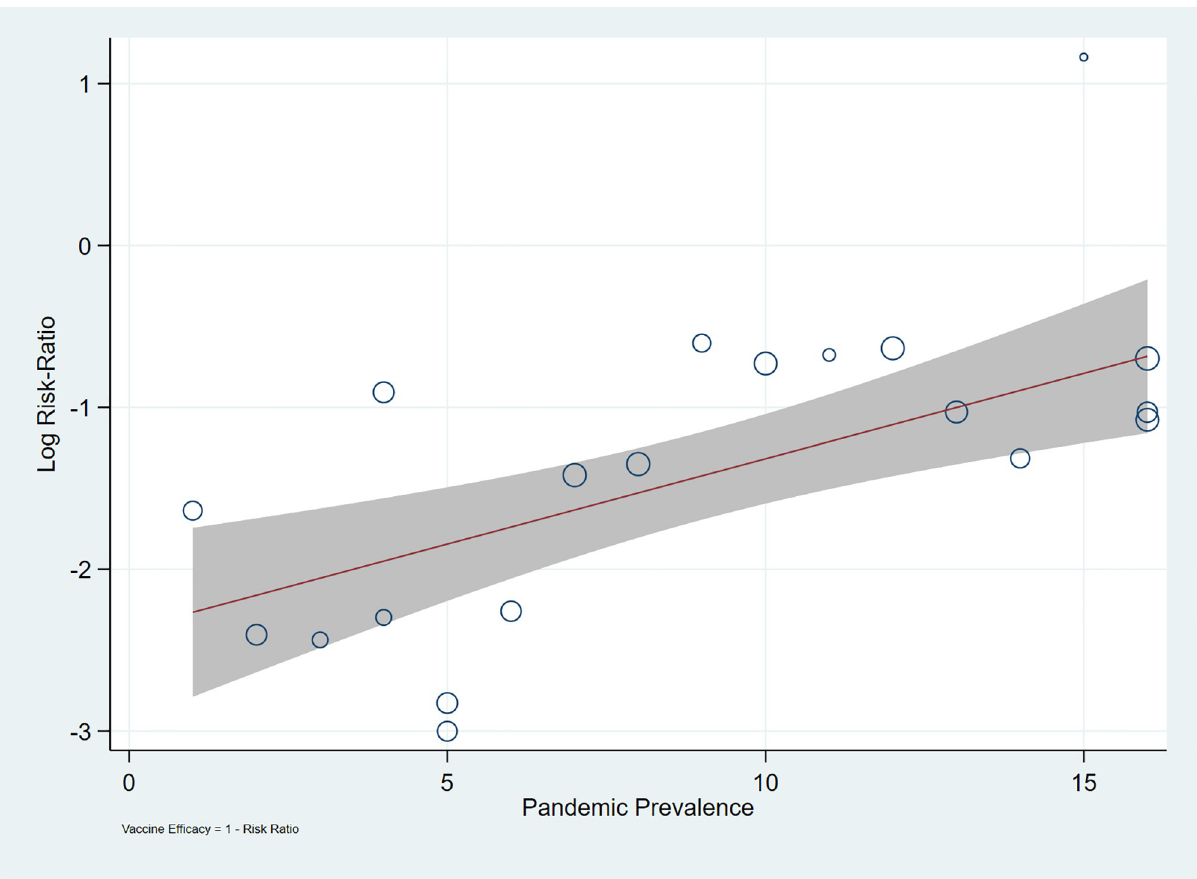
Fig 4. Association of pandemic prevalence on vaccine efficacy.